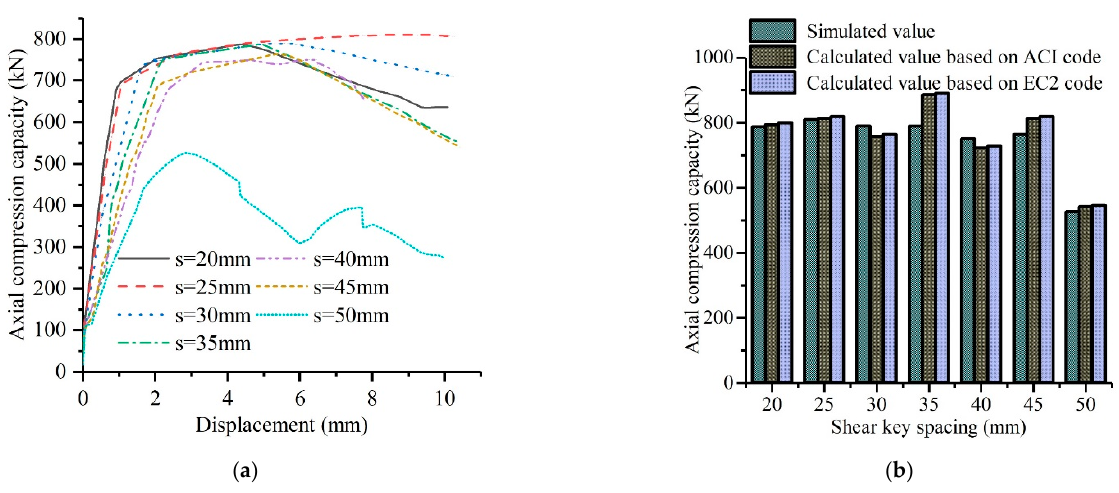
Figure 17. Different shear key distances: ( a ) comparison of load–displacement curves of different shear key distances; ( b ) comparison of calculated and simulated values of different shear key distances.